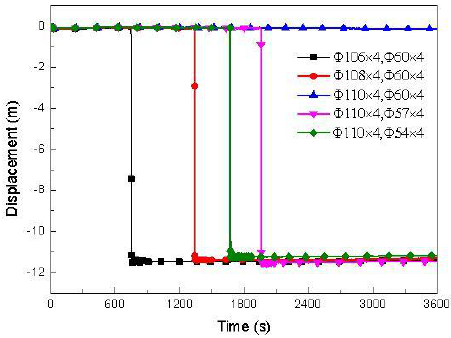
Figure 23. Time-history curve of vertical displacement (influence of the members).